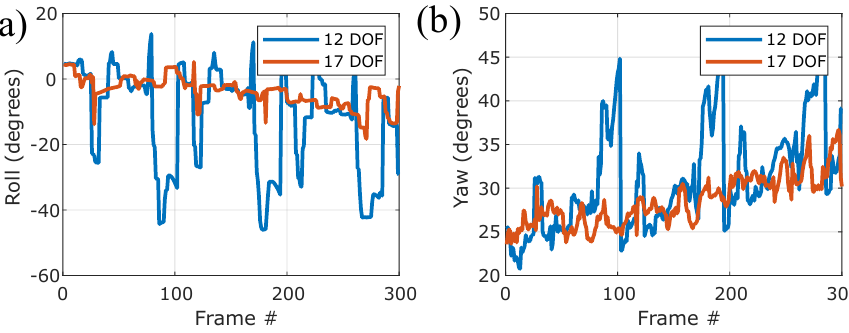
Figure 10. Comparison between the 12-DOF and 17-DOF models. The body roll ( a ) and yaw ( b ) angles found using the 12-DOF (blue) and 17-DOF (red) models, both for the same unperturbed, non-maneuvering flight data.